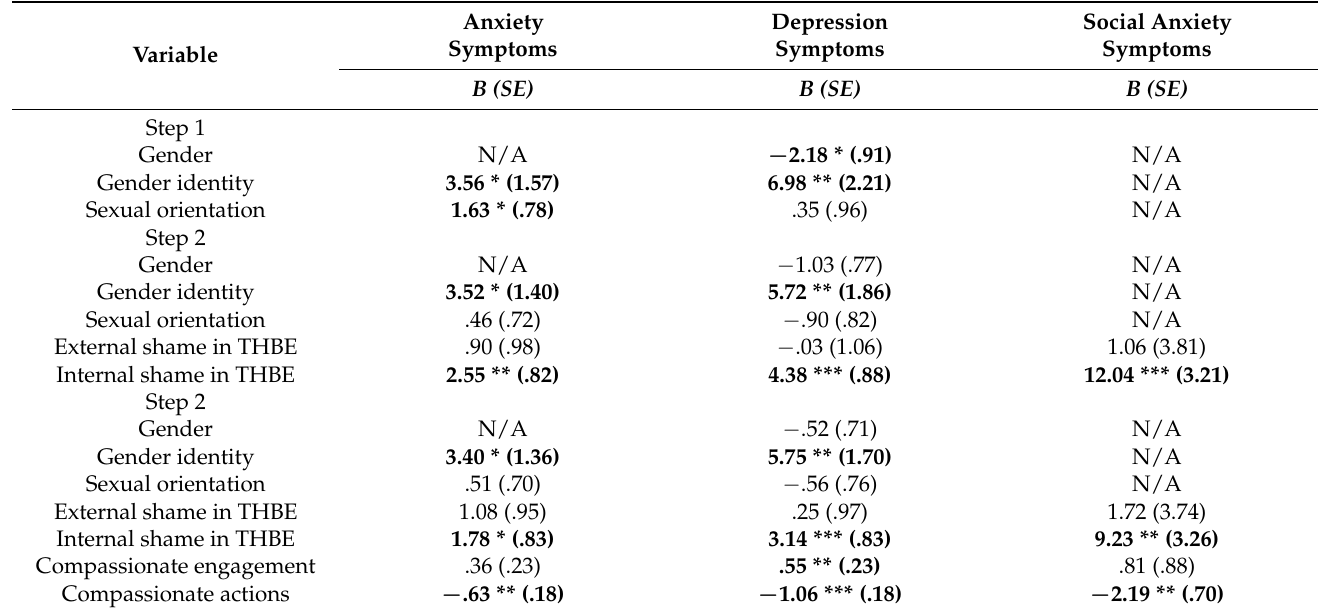
Table 3. Hierarchical regression results for anxiety, depression, and social anxiety ( n = 181).